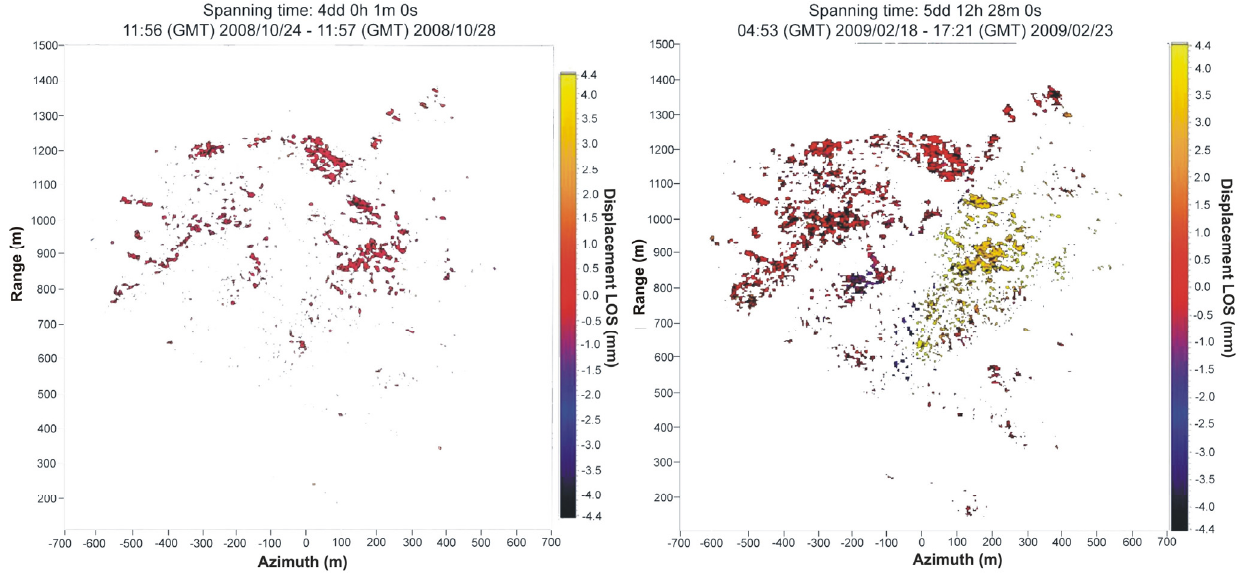
Figure 7. Interferograms elaborated from the data acquired during the first two campaigns. On the left, interferogram spanning a time interval of four days (between 24 and 28 October 2008); on the right, interferogram relative to the second campaign spanning a time interval of five days (between 18 and 23 February